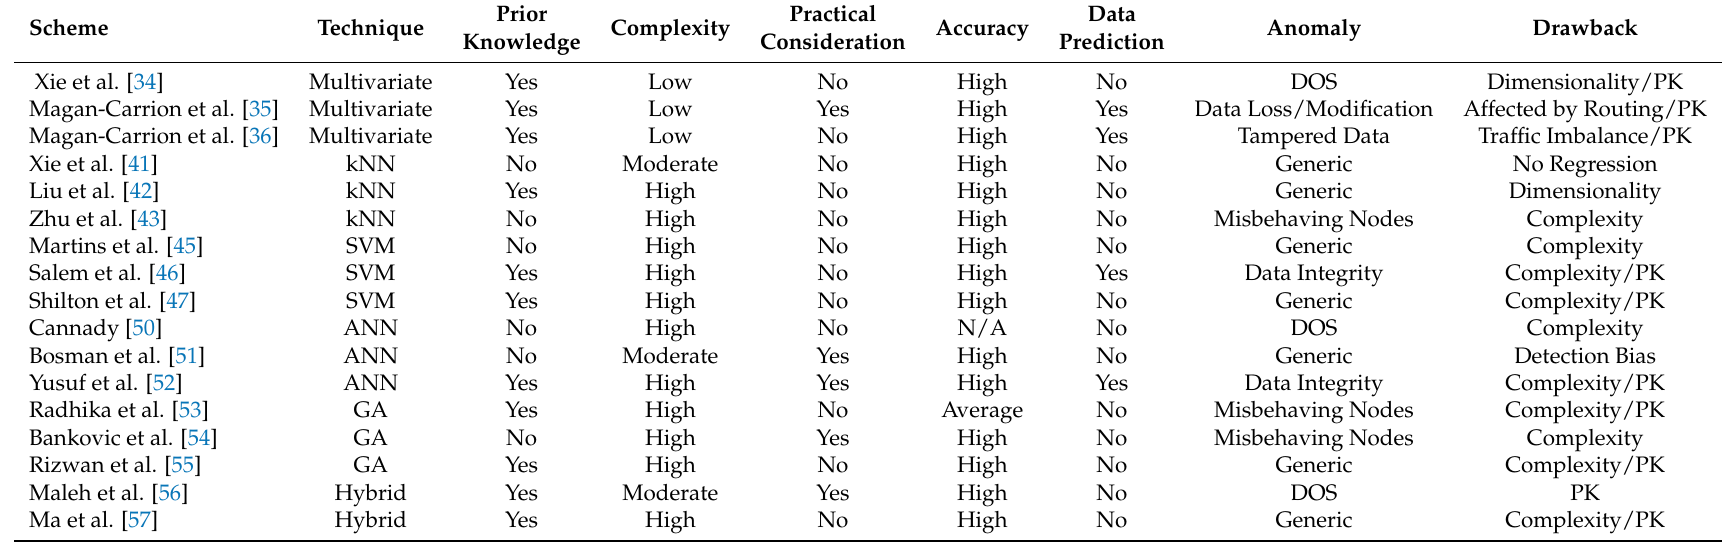
Table 3. A comparison of the discussed anomaly detection